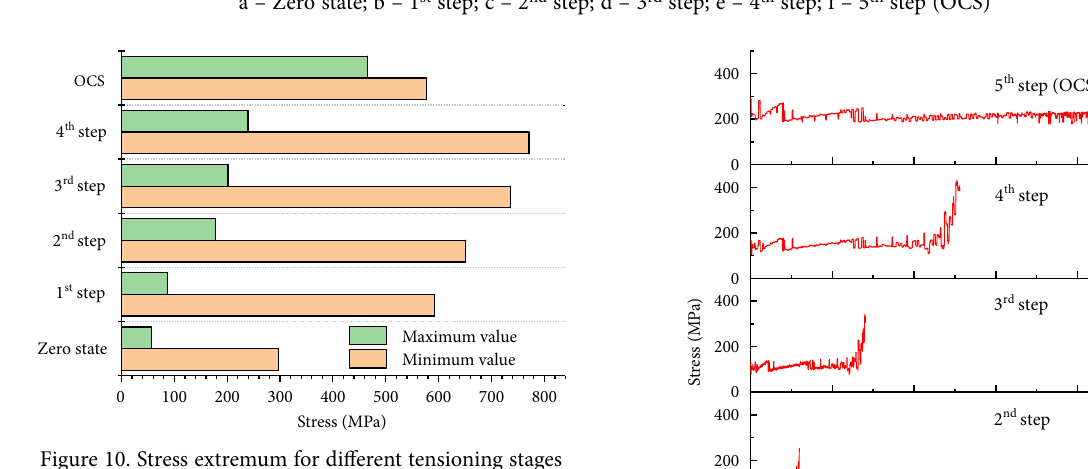
Figure 9. Stress nephogram at different tensioning